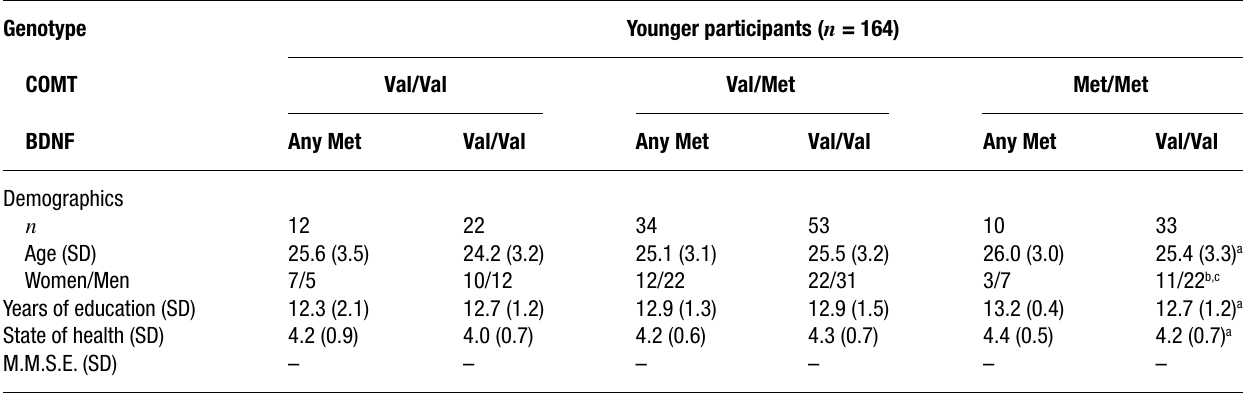
State of health is based on four self-ratings assessed on 5-point scales (1 = poor; 5 = excellent). a Two-way analyses of variance = n.s. b χ 2